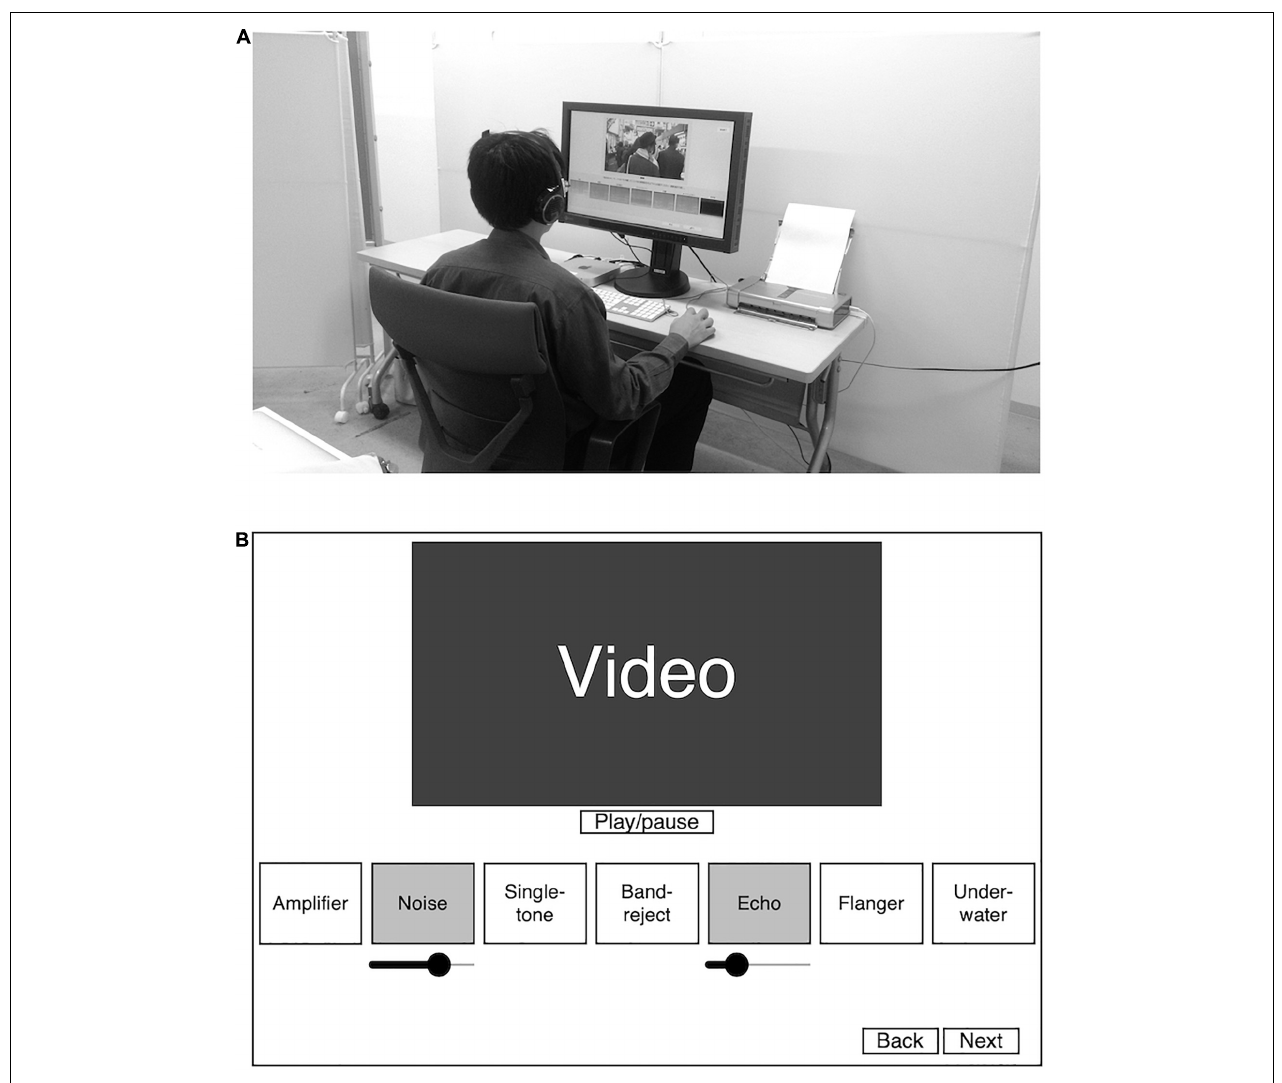
FIGURE 1 | The environmental setting of the experiment (A) and the interface used in the experiment (B)